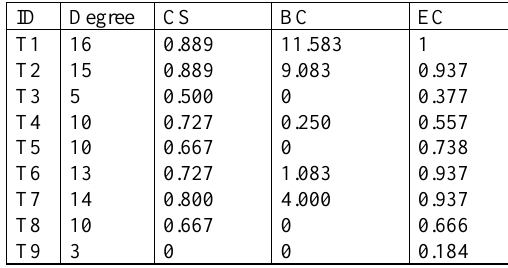
Table 1 . Centrality